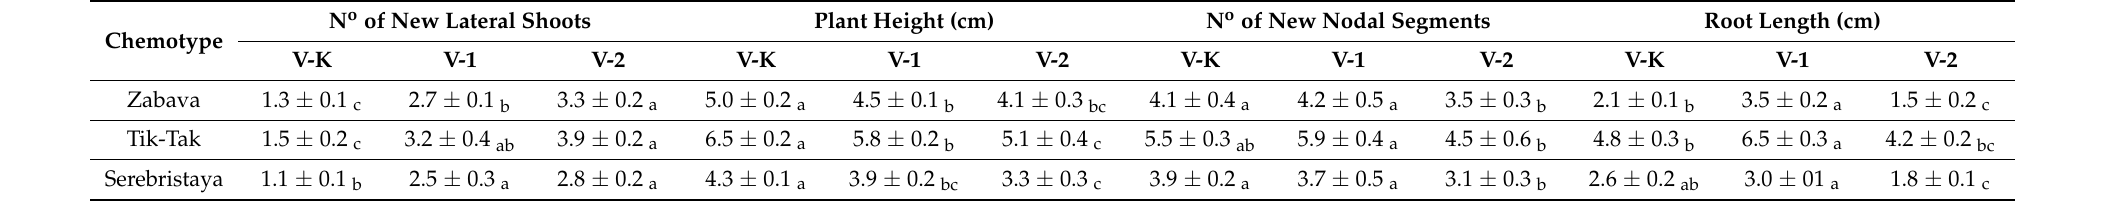
Table 1. Average values of indicators after four weeks of in vitro culture of initial explants of